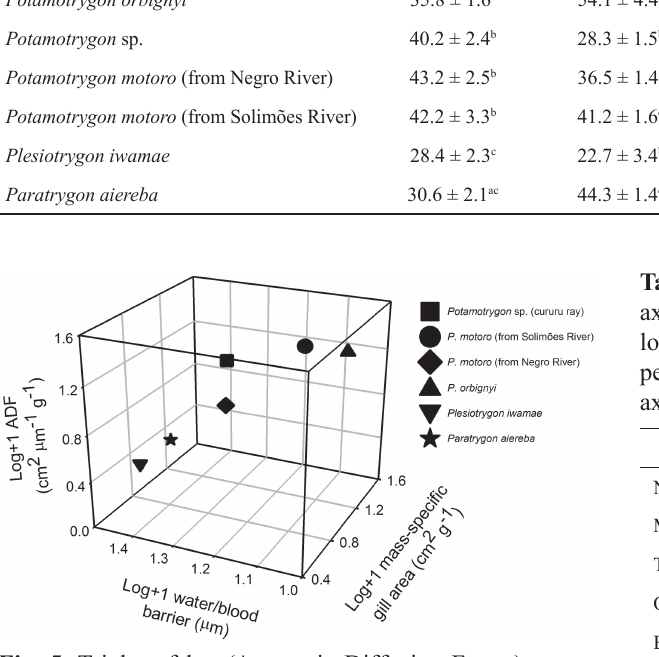
Fig. 5 . Triplot of log (Anatomic Diffusion Factor) versus log(water/blood barrier thickness) versus log(mass-specific gill area) of the potamotrygonid embryos.